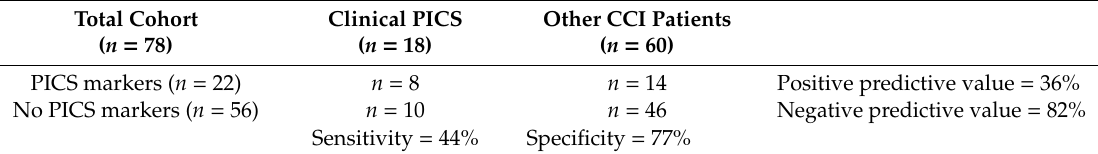
Table 3. PICS markers tested for sensitivity and specificity in the study population.